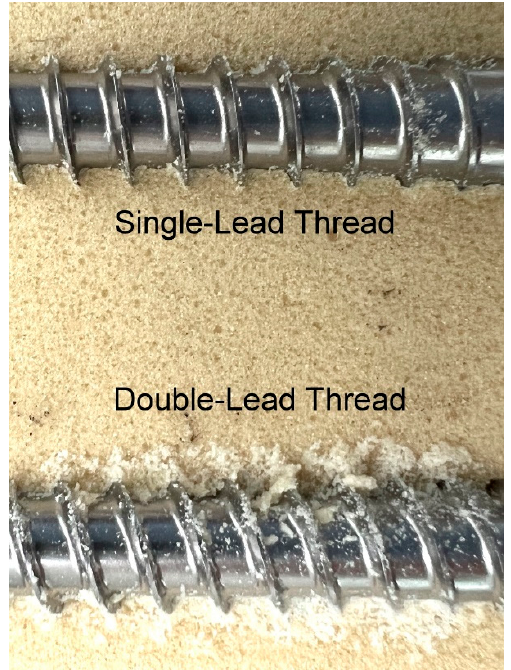
Figure 6. Observations of the artificial bone implant for Screw D (single-lead) and Screw H (double-lead).